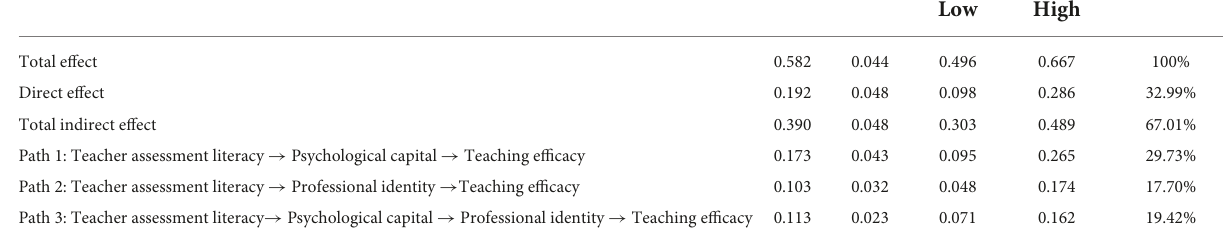
TABLE 3 Multiple mediated analysis between the teacher